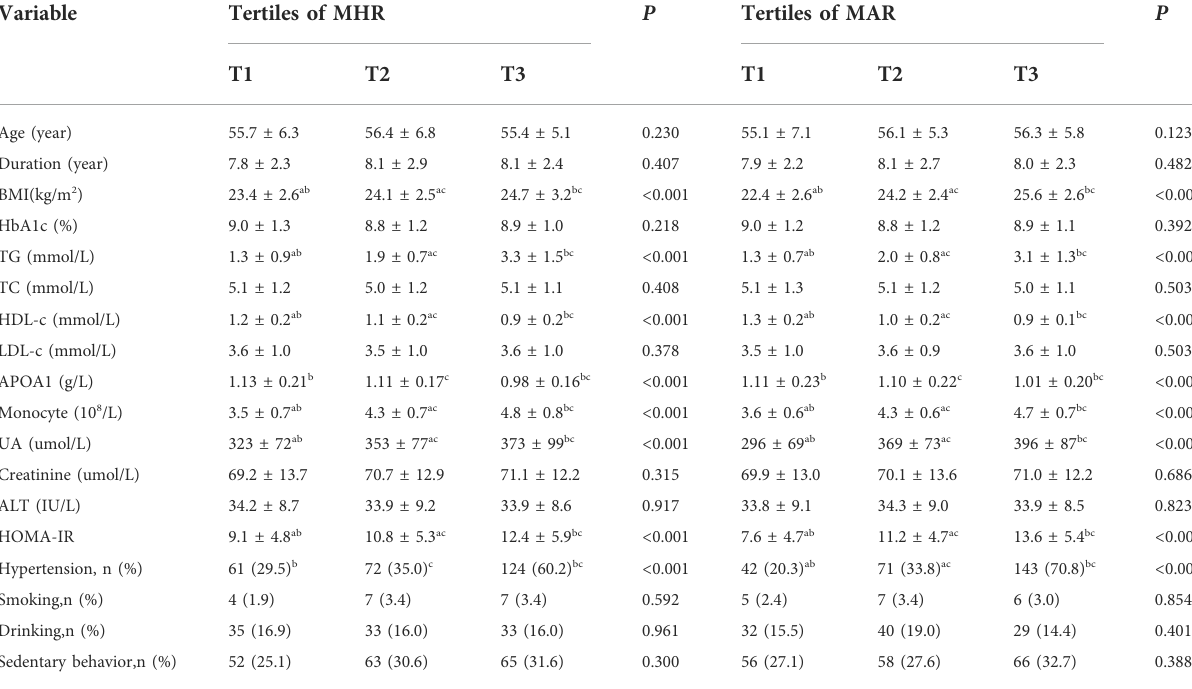
TABLE 1 Clinical and laboratory characteristics of participants based on tertiles of MHR (10 8 /mmol) and MAR (10 8 /g).